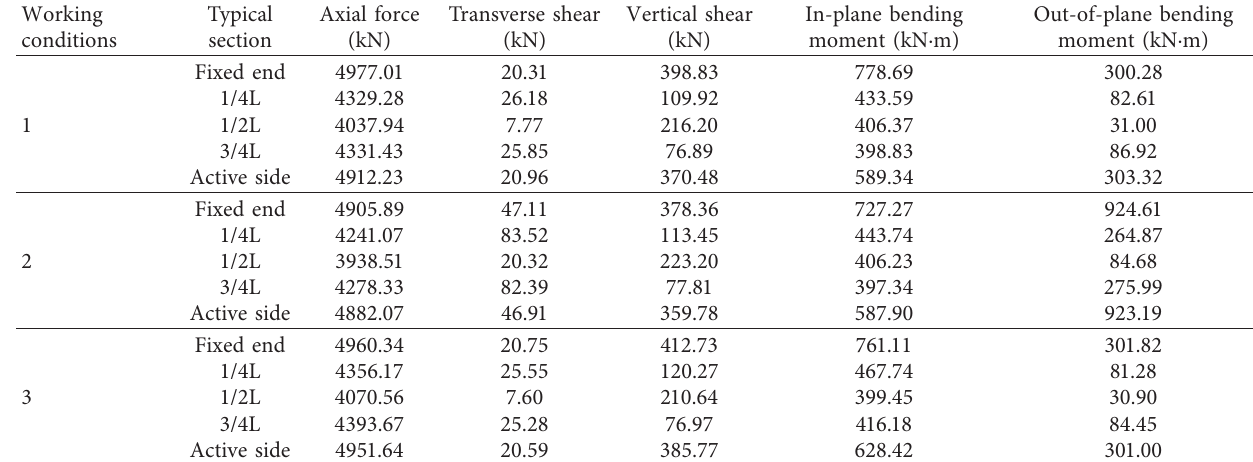
Table 6: The peak values of the internal force of the bridge.